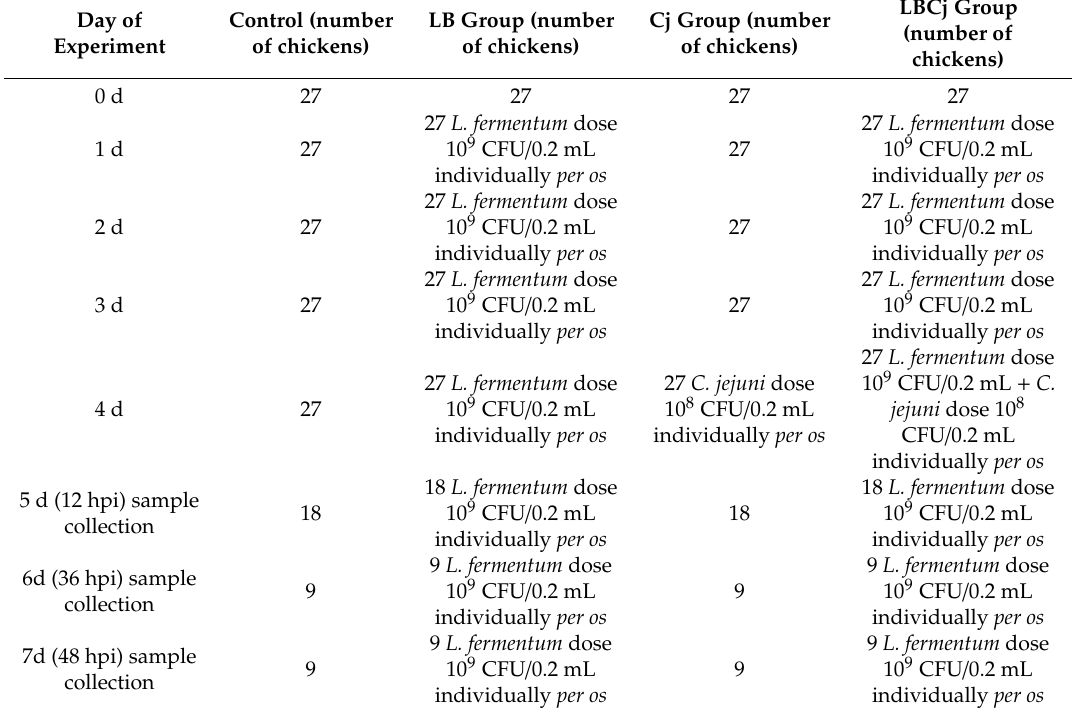
Table 1. Schema of the methodology aimed at measuring cytokine transcript modulation in chickens exposed to L. fermentum and C. jejuni